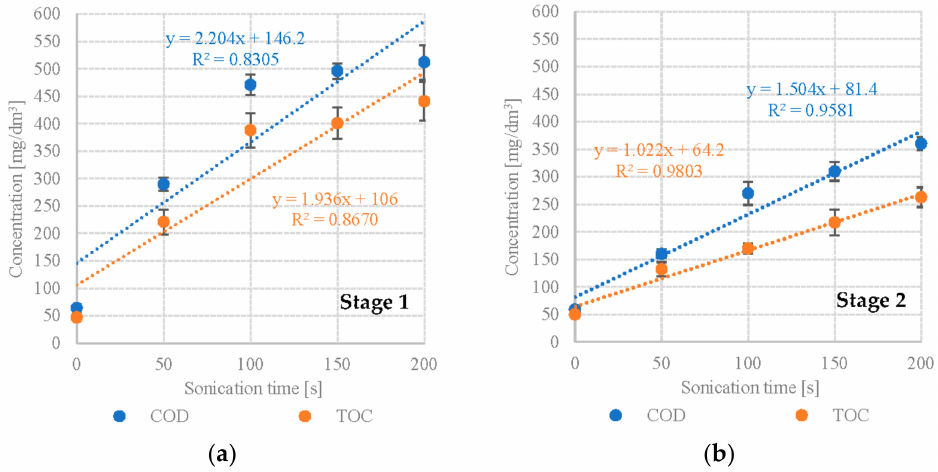
Figure 1. Correlations between UD exposure time and levels of dissolved organic compounds ( a ) S1— Scenedesmus sp., ( b ) S2— Pinnularia